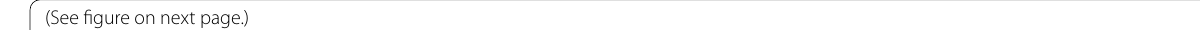
(See figure on next page.) Fig. 1 Inset: simplified map of Costa Rica with the location of Irazú and Turrialba volcanoes at the SE termination of Cordillera Central volcanic ridge. White triangles are volcanoes. The inset is a sketch of Central America geodynamics dominated by the Cocos‑Caribbean subduction. a Morpho‑structural sketch map of Irazú and Turrialba volcanoes, showing the main volcanic and tectonic features in the study area. The Hillside or ShadowRelieve image was elaborated by Y. Alpízar on the basis of the topographic maps 1:50,000 scale from the National Geographic Institute of Costa Rica. Symbols as in Fig. 2b. Numbered points in the figures indicate meters above sea level. b Sampling points of main fumaroles ( FUM Irazù fumaroles, AQ Arbol Quemado fracture) and crater lakes ( IL Irazú lake, TL Turrialba lake) in the summit of Irazú and Turrialba volcanoes, together with location of the studied thermal springs ( SC San Cayetano, ST Santa Teresita, OJA Ojo de Agua, BLP Bajo Las Peñas, HBA Hervideros de Buenos Aires) and water sampling points from the rivers along the volcano flanks (white triangles). Labels of sampling points conform to the following diagrams and